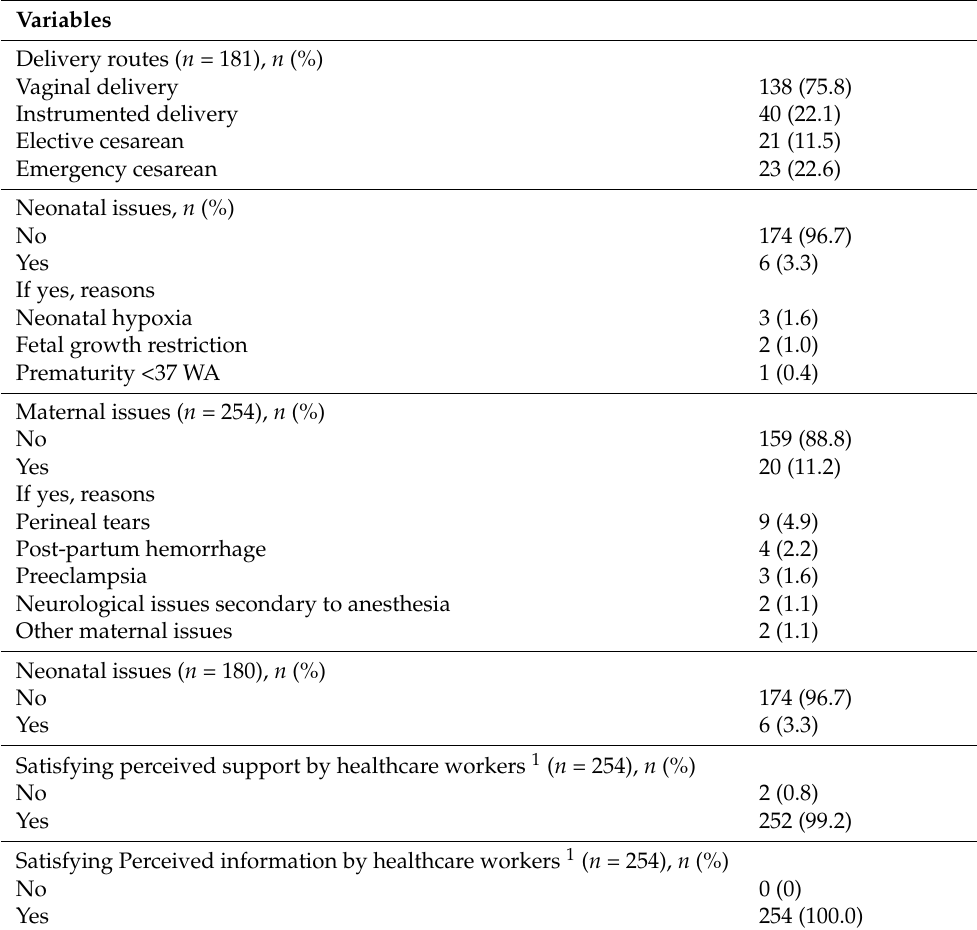
Table 2. Delivery routes, maternal and neonatal complications and perceptions of support and information provided by healthcare